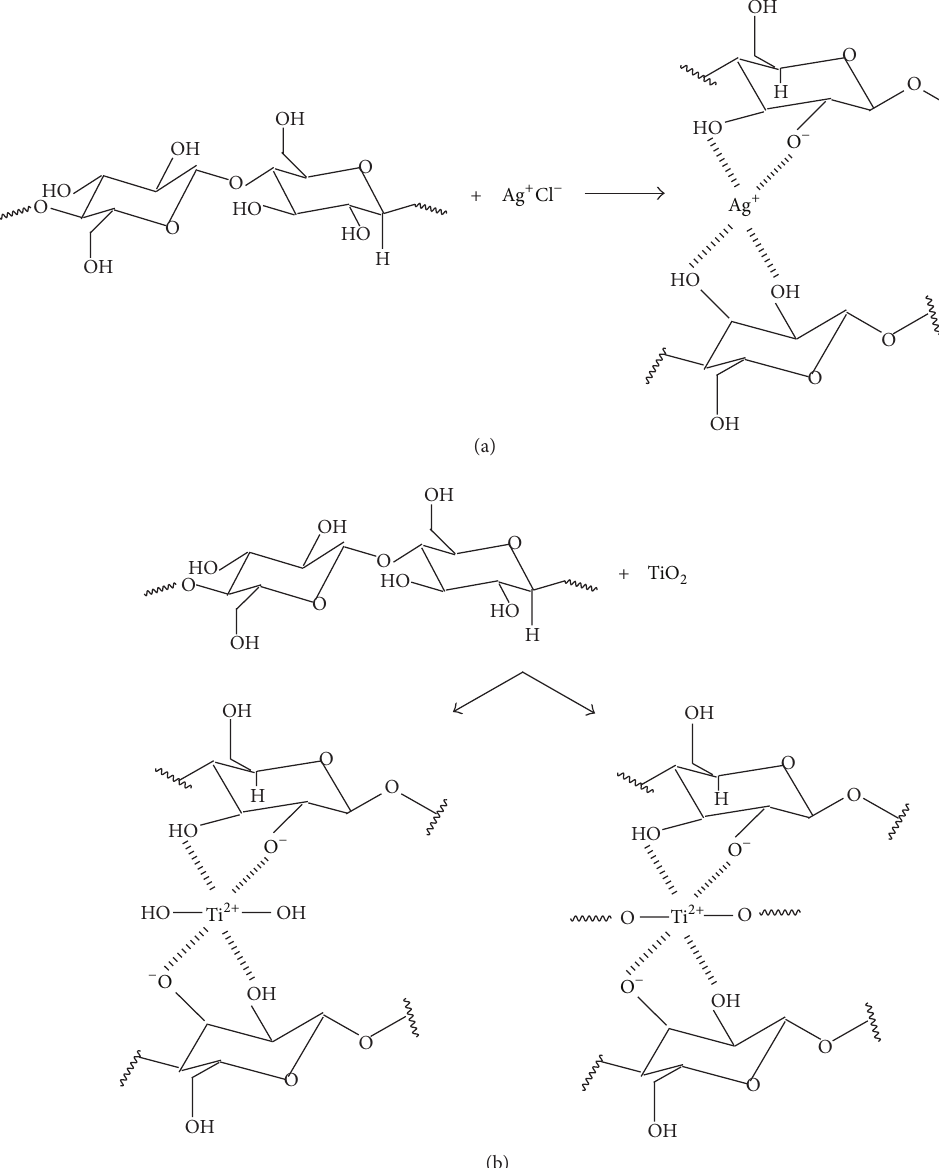
Scheme 4: Possible reactions occurring as a result of treating cotton/cellulose with silver chloride (a) and titanium dioxide (b) in the presence of water in weak acid